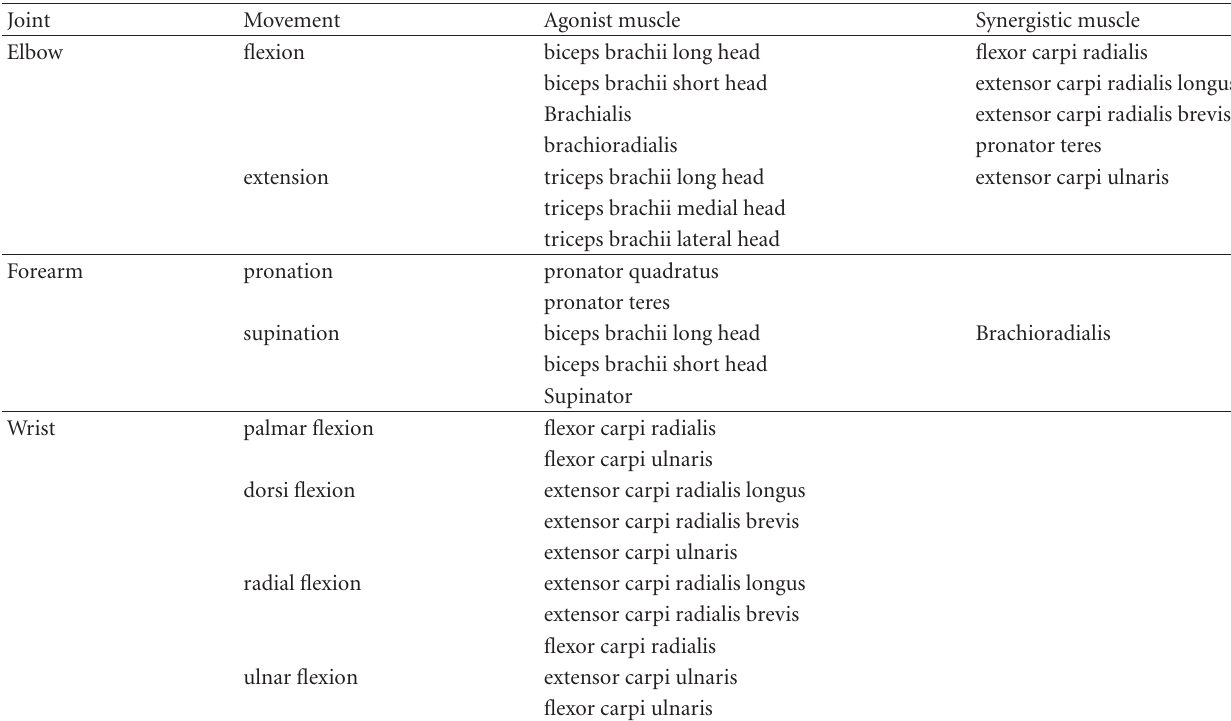
Table 1: Muscles included into the